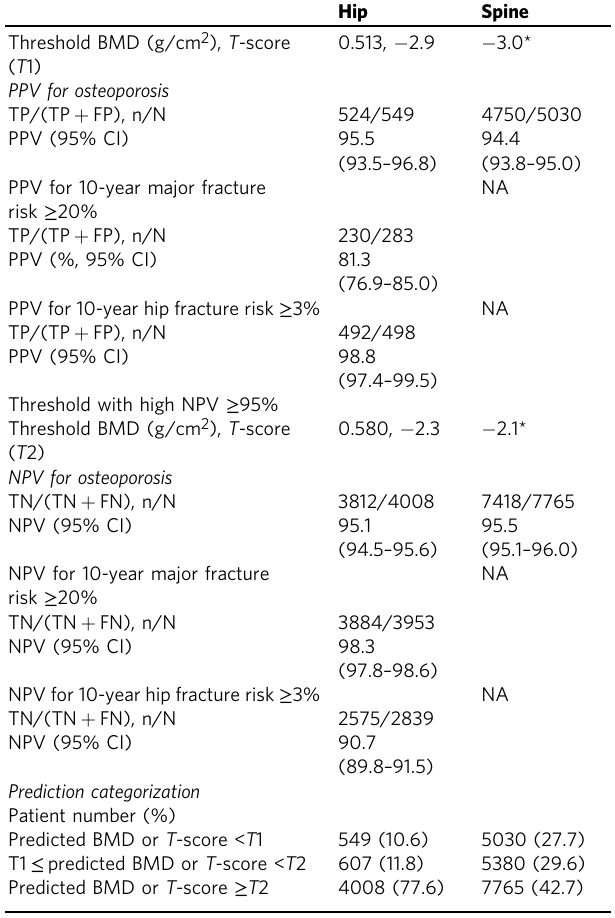
Table 4 Osteoporosis classi fi cation results at 95% PPV and 95% NPV thresholds on Hologic testing